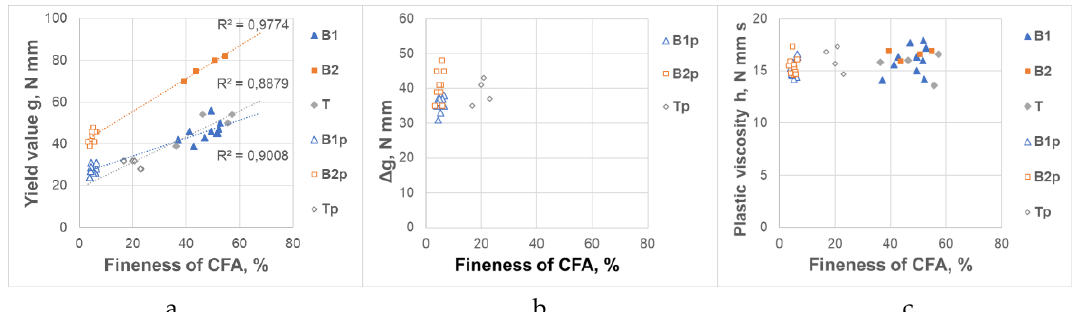
Figure 5. Influence of fineness of CFA on rheological properties of CFA mortars. ( a ) Yield value g; ( b ) Increase of the yield value g in time Δg, ( c ) Plastic viscosity h.